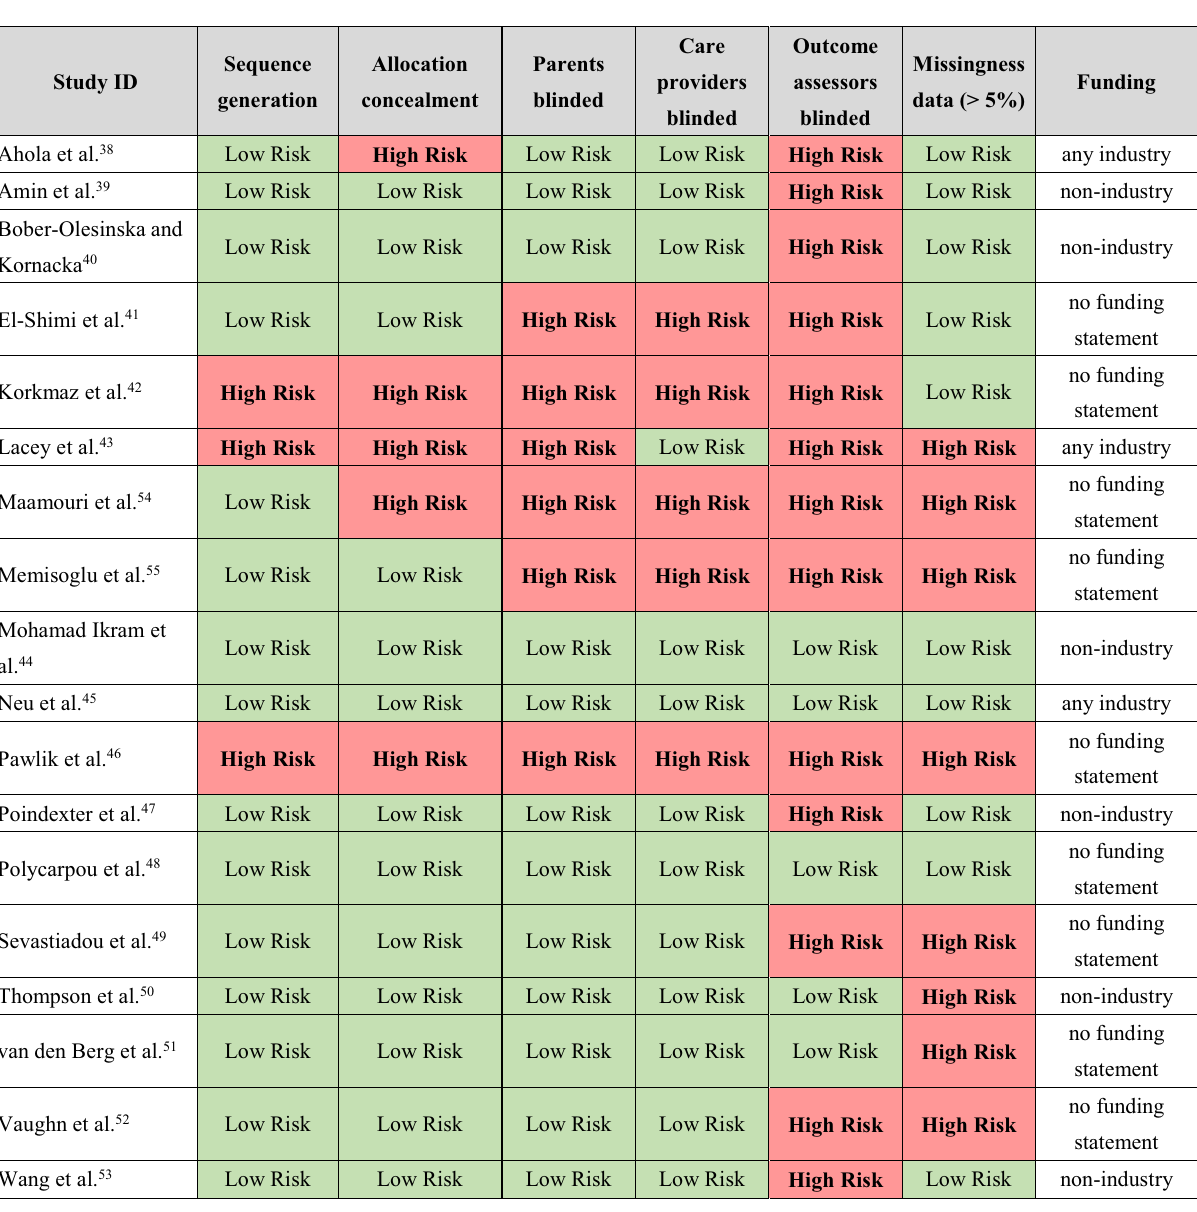
Table 2. Summary of risk of bias assessments for included